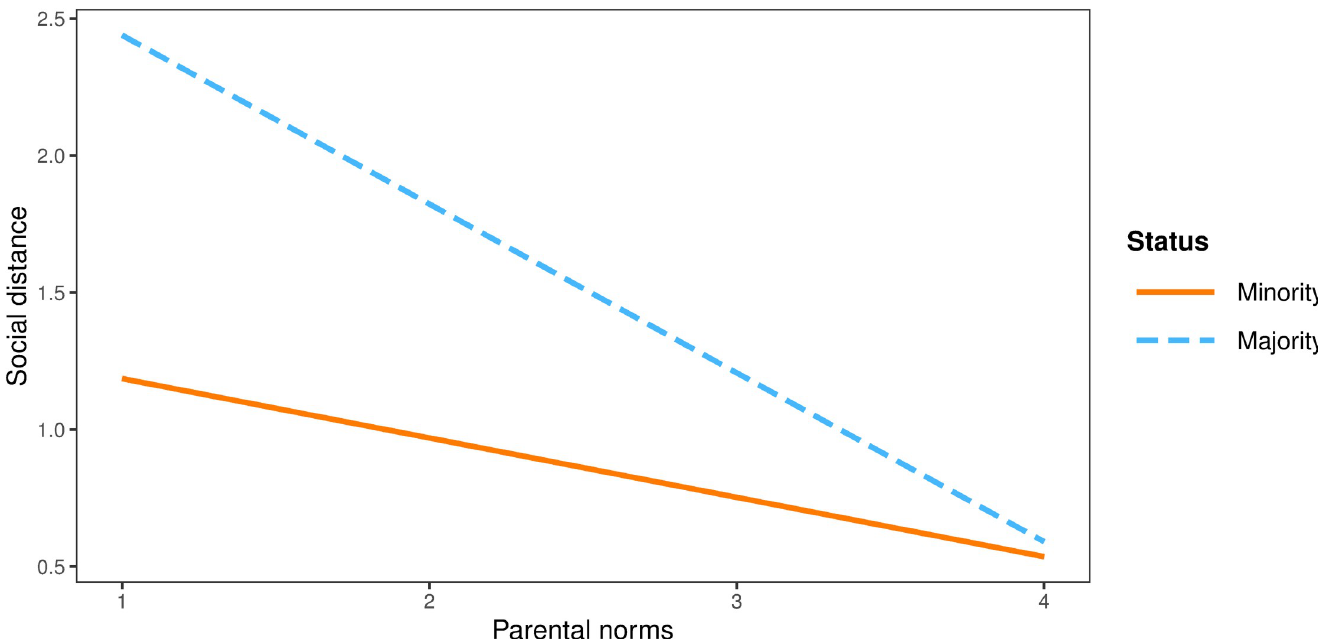
Fig 5. Interaction plot between parental norms and group status on social distance.